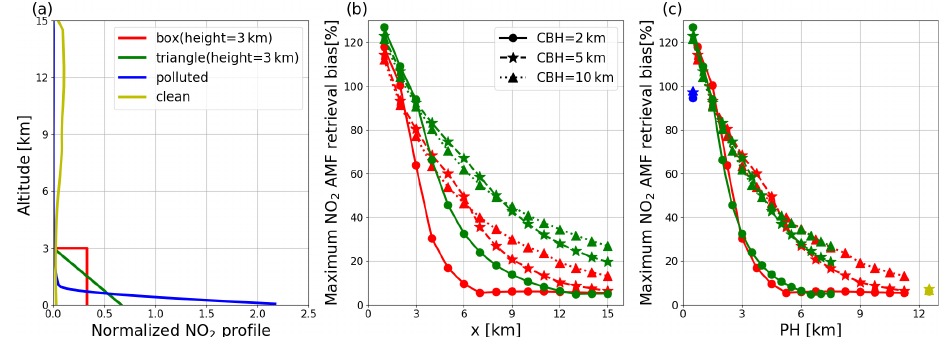
Figure 5. Dependence on NO 2 profile shape of the NO 2 AMF bias in the cloud shadow. (a) Selected NO 2 profile shapes. (b) Largest AMF retrieval biases for the cases with liquid water cloud at different altitudes, as a function of the model height. Panel (c) similar to panel (b) but as a function of the profile height parameter. See text for further